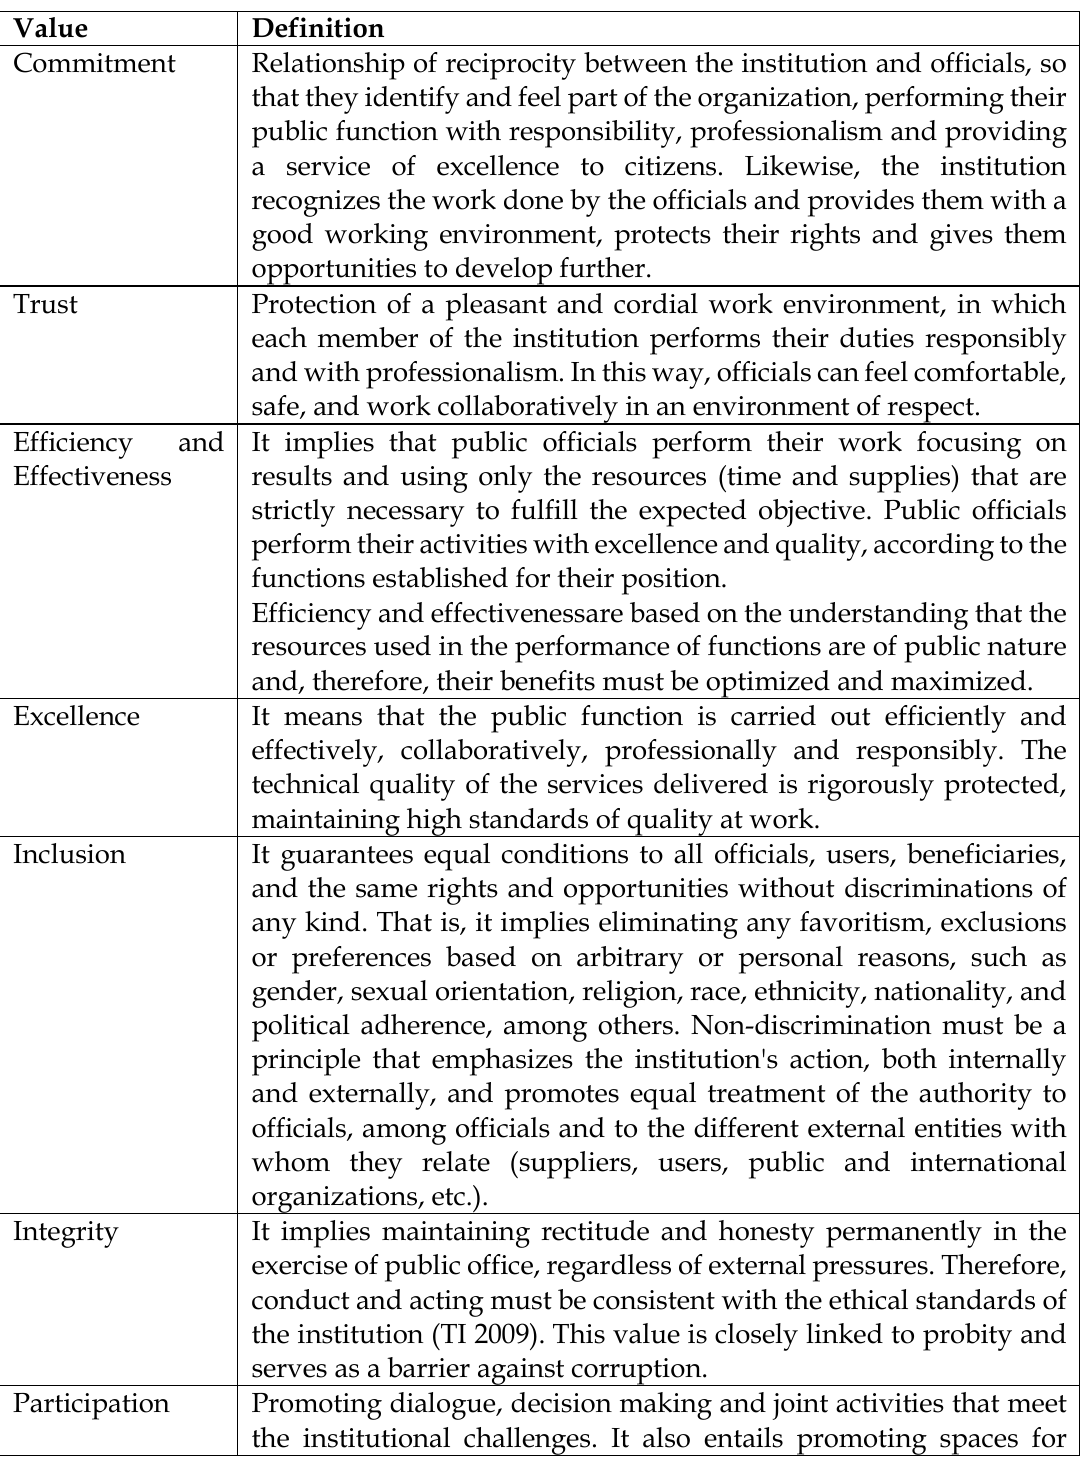
Table 2: Glossary of